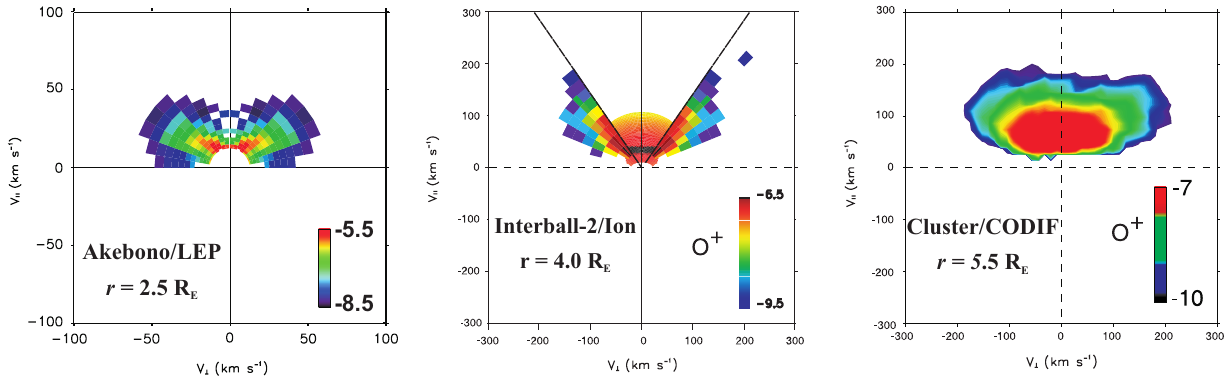
Fig. 2. From the left to the right, 3 examples of ion velocity distributions in cm − 3 km − 3 s 3 measured by Akebono/LEP at r =2.5 R E , Interball-2/Ion at r =4.0 R E , and Cluster/CODIF at r =5.5 R E